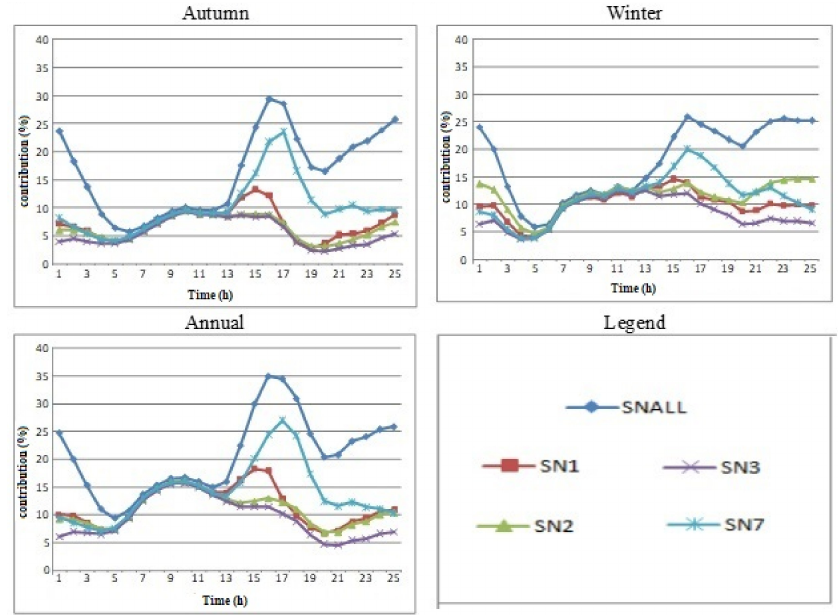
Figure 15. Annual and seasonal averaged relative contribution (%) of all the emissions and the emissions from different SNAP categories of the formation of NO 2 concentrations for Bistritsa for the period 2008–2014.